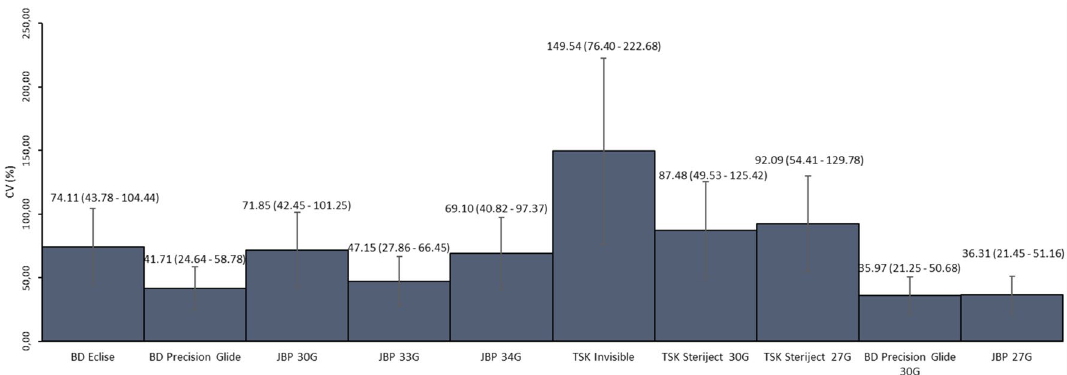
Figure 3. Coefficients of variation (CV) (%) of the needle